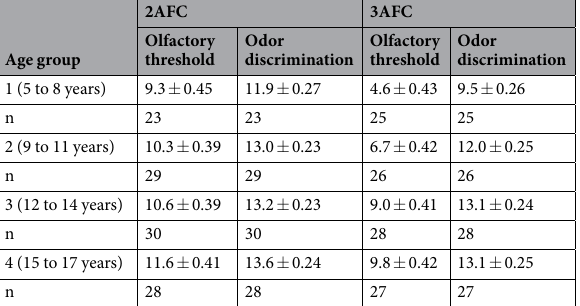
Table 1. Scores of age groups measuring olfactory threshold and odor discrimination with 2AFC and 3AFC method (means ± standard error; n: number of subjects). Olfactory threshold scores in phenyl ethyl alcohol dilution steps; odor discrimination scores in number correctly performed